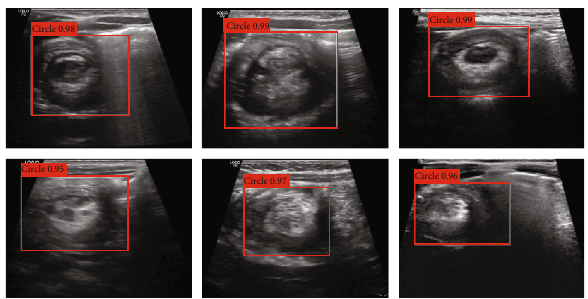
Figure 6: Ultrasound images of pediatric intussusception in the validation set.